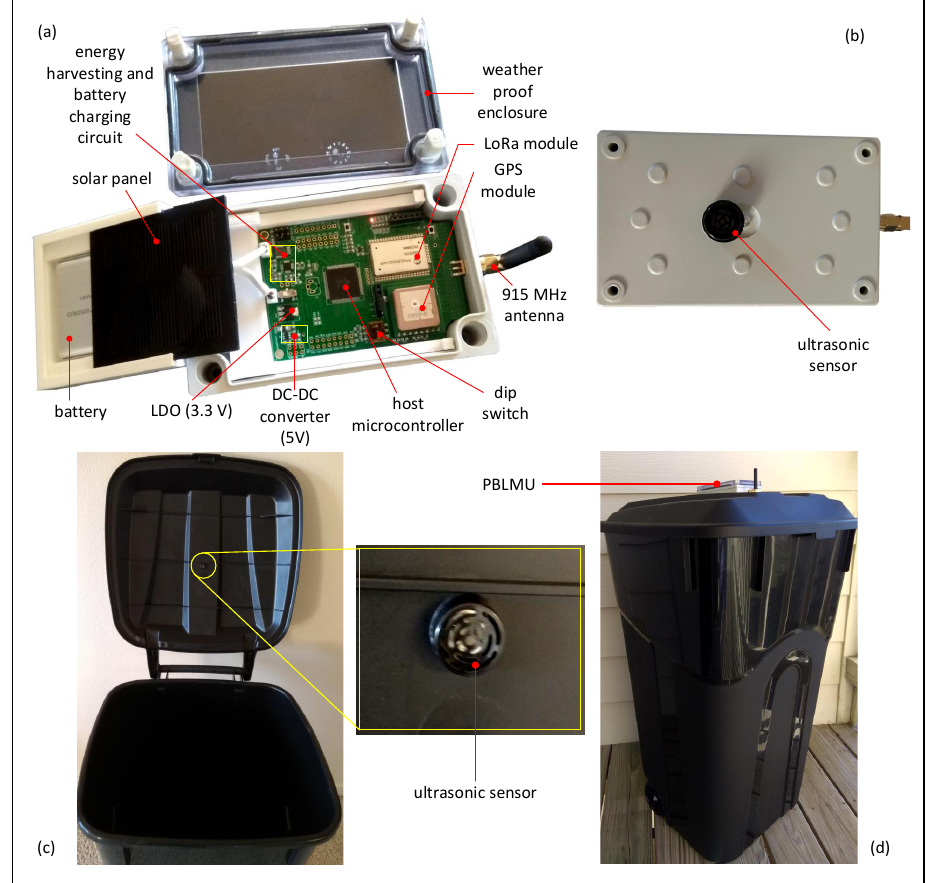
Figure 5. ( a ) Various components of the fabricated PBLMU. ( b ) Rear view of the fabricated PBLMU. ( c ) Installation of PBLMU on a trash bin. ( d ) Front view of the PBLMU equipped trash bin.